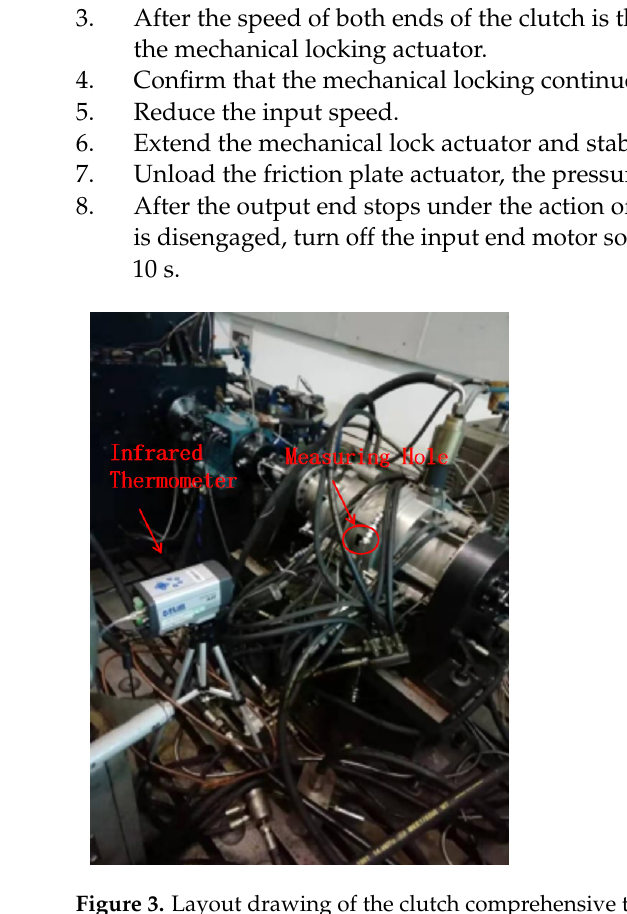
Table 1. Basic physical and mechanical properties of carbon/carbon friction sheet [17–19].